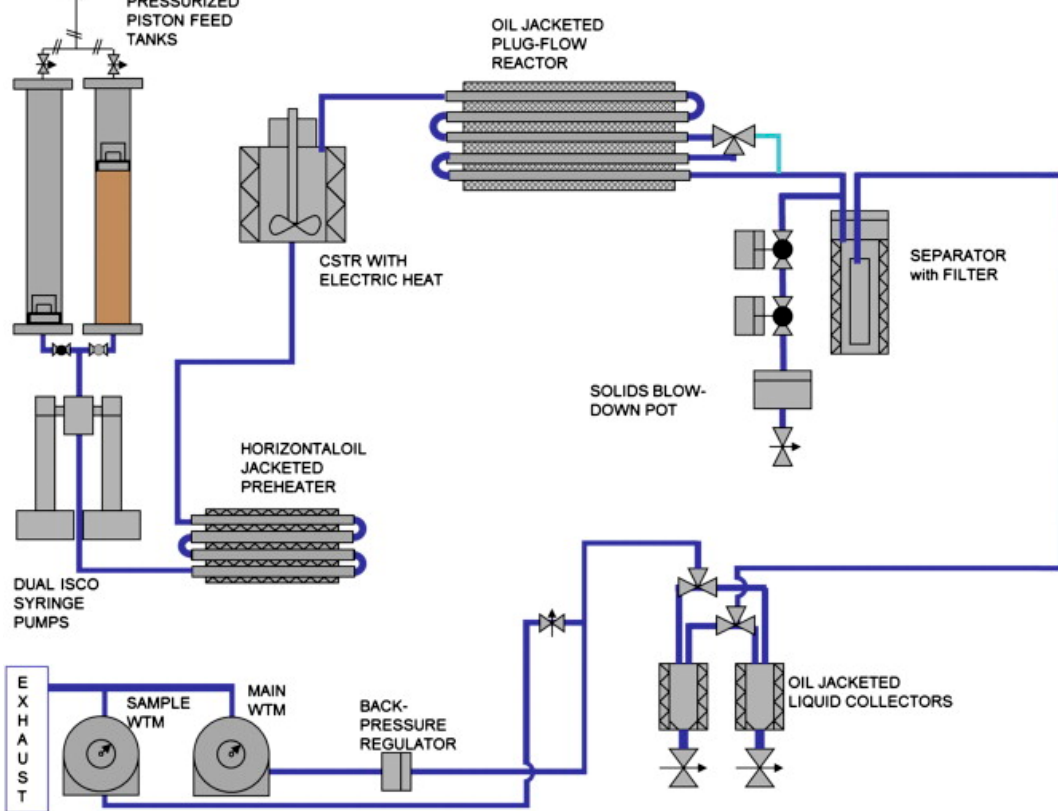
Figure 4. Process scheme of the plant in Pacific Northwest National Laboratories (PNNL).